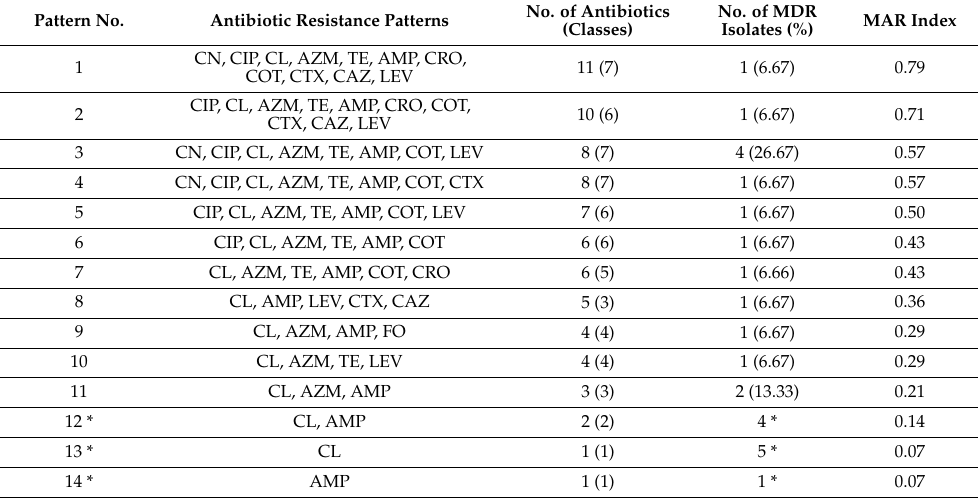
Table 2. Phenotypic multidrug resistance profiles and multiple antibiotic resistance index profiles of C. freundii isolated from cloacal swabs of